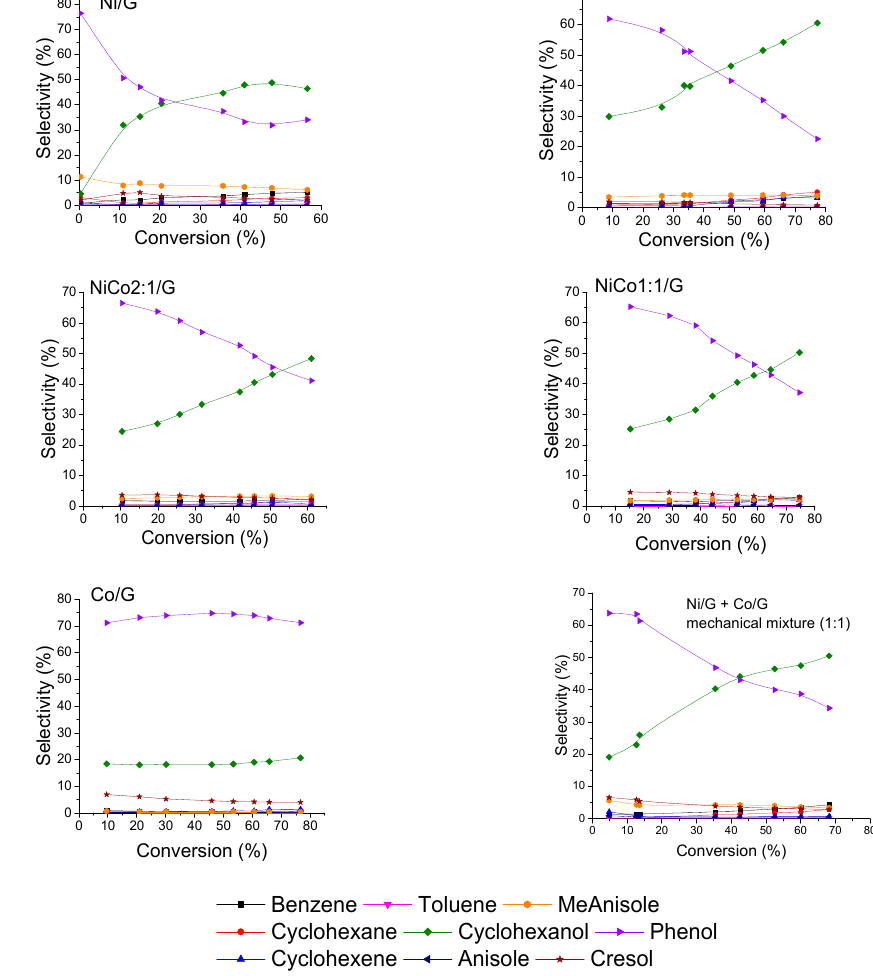
Figure 8. Evolution of the product selectivities with guaiacol conversion for each catalyst at 300 °C, 50 bar.